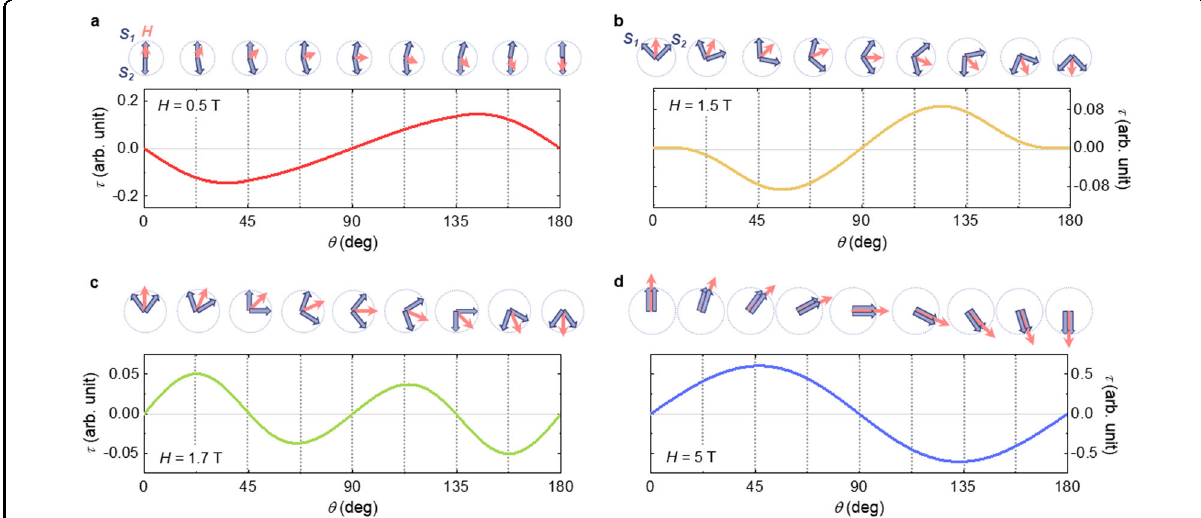
Fig. 5 Direct connection between spin states and angle-dependent torques at room temperature. a Angular dependence of magnetic τ calculated by fi tting to the experimental τ data at T = 300 K. H is rotated in the ac plane with H = 0.5 T. The schematics depict the con fi gurations of the net magnetic moments in the upper ( S 1 ) and lower ( S 2 ) layers with respect to the H direction. b , c , and d Calculated angle-dependent τ and corresponding net moment orientations at H = 1.5, 1.7, and 5 T,